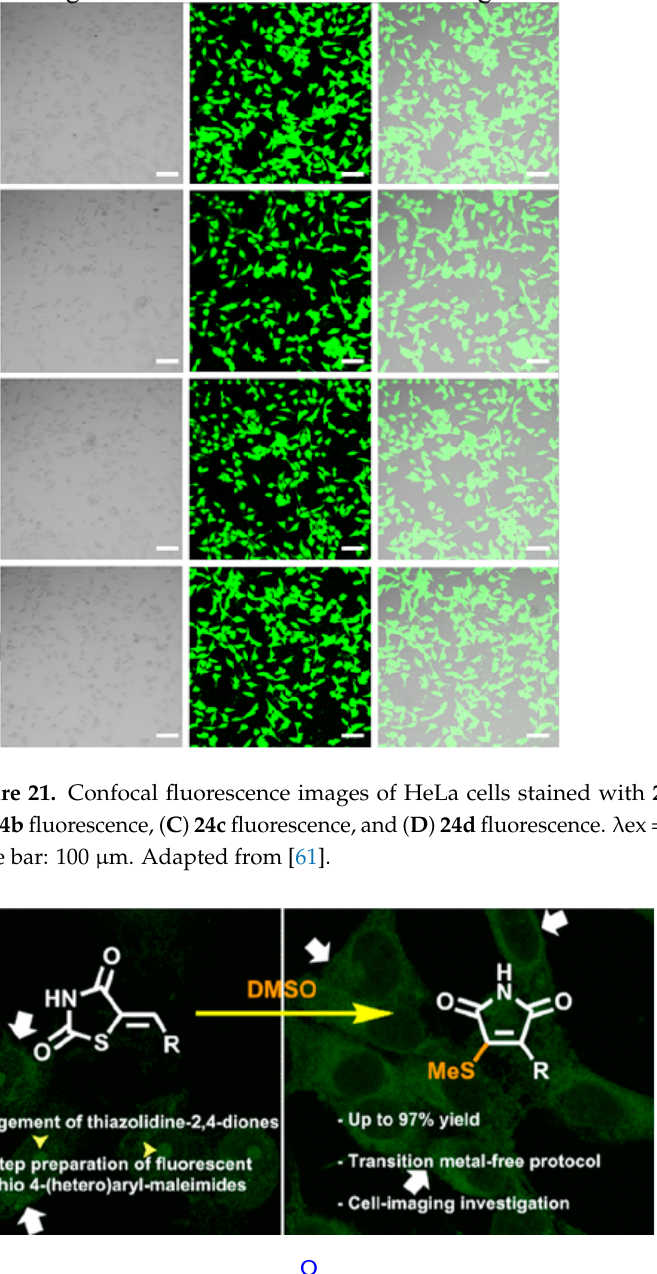
Figure 21. Confocal fluorescence images of HeLa cells stained with 24a – d . ( A ) 24a fluorescence, ( B ) 24b fluorescence, ( C ) 24c fluorescence, and ( D ) 24d fluorescence. λ ex = 405 nm. λ em = 460 − 550 nm. Scale bar: 100 μ m. Adapted from [61].